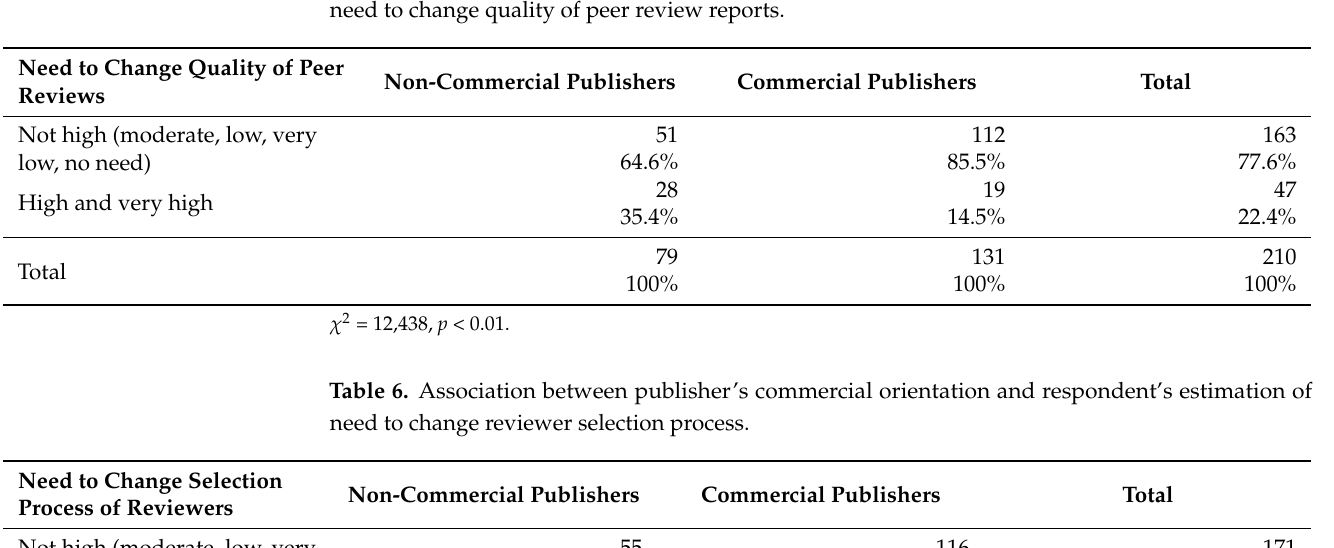
Table 5. Association between publisher’s commercial orientation and respondent’s estimation of need to change quality of peer review reports.